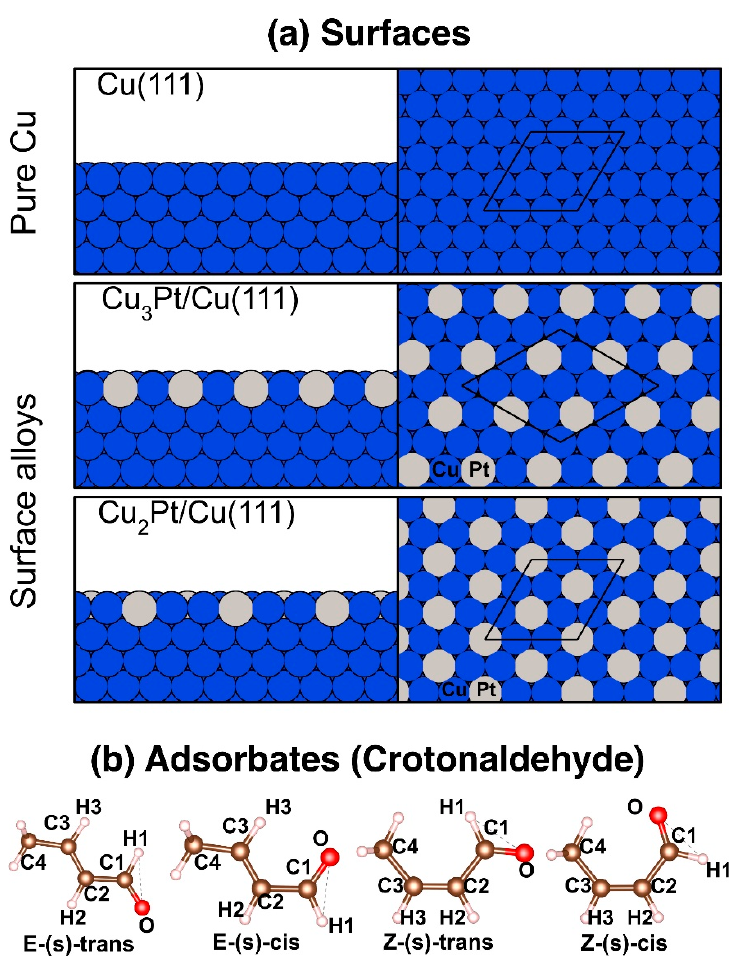
Figure 1. ( a ) Side (left) and top (right) views of the pristine Cu(111) and of the simulated Cu 3 Pt/Cu(111) and Cu 2 Pt/Cu(111) alloy surfaces used in this study. The corresponding (3 × 3), (2 √ 3 × 2 √ 3)R30°, and (3 × 3) supercells are shown in the top views. ( b ) Optimized structures for the different configurations of crotonaldehyde in the gas phase.